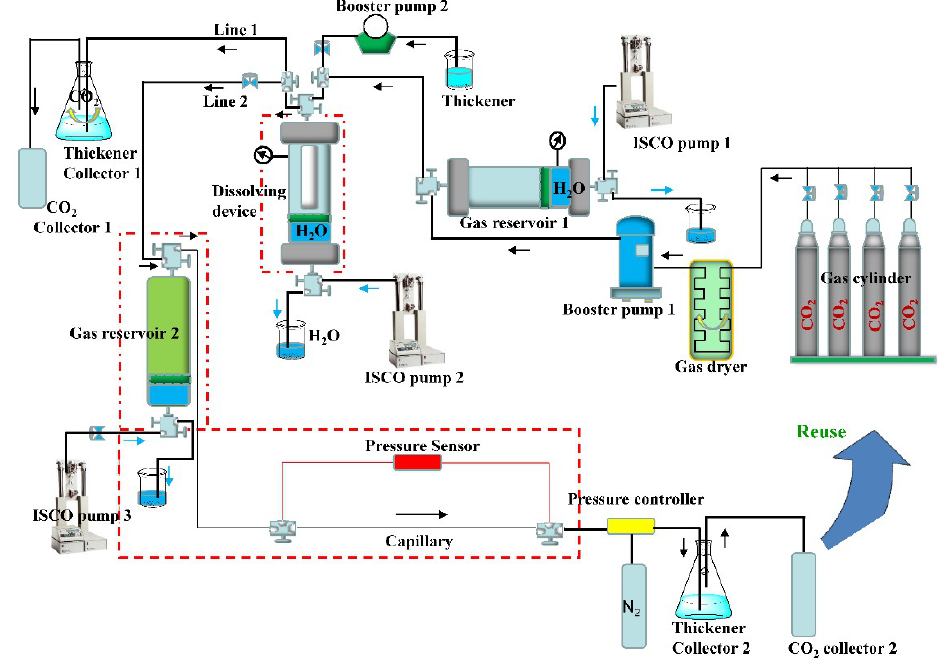
Figure 2. The composition of this capillary